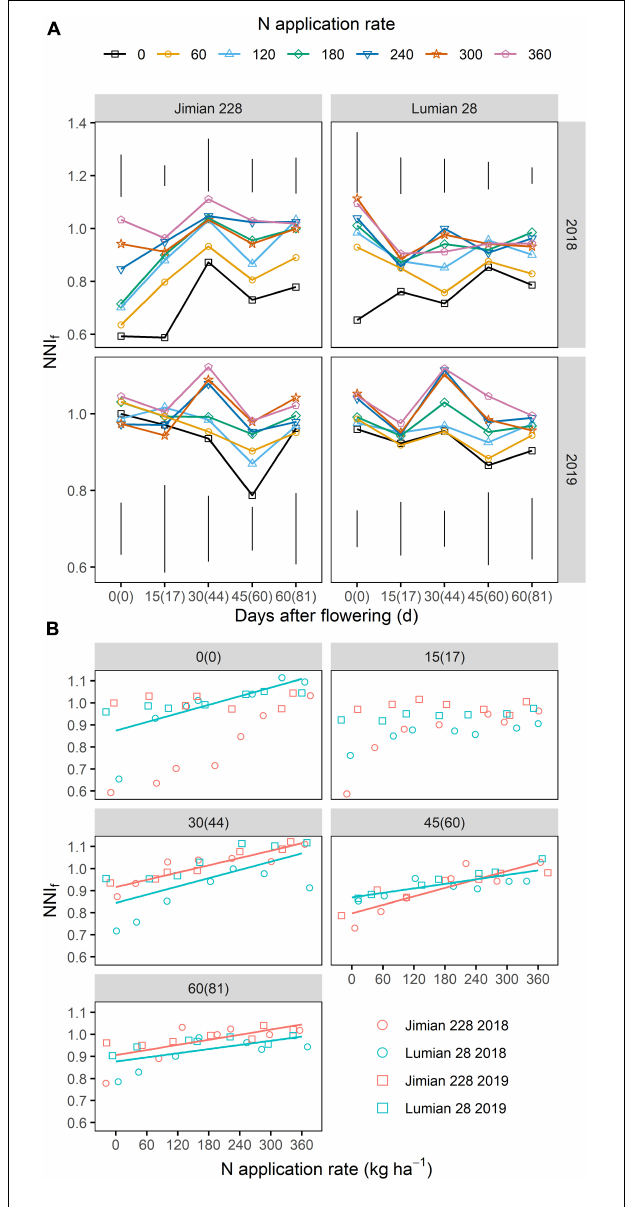
FIGURE 5 | The nitrogen nutrition index of cotton fruits (NNI f ) after flowering (A) and its relationship with N application rate (B) . The numbers without and with brackets are the days after flowering corresponding to sampling dates in 2018 and 2019, respectively. (A) The vertical bars indicate Tukey’s HSD error bars at each sampling date. For clarity purposes, standard error at each sampling date is not shown in the graphs. ANOVA table is shown in Supplementary Table 5 . (B) Points shown for the mean values of the three replicate plots. The red and blue solid lines represent significant linear relationships ( P < 0.05) for Jimian 228 and Lumian 28 across 2 years, respectively; non-significant relationships are not shown ( P >